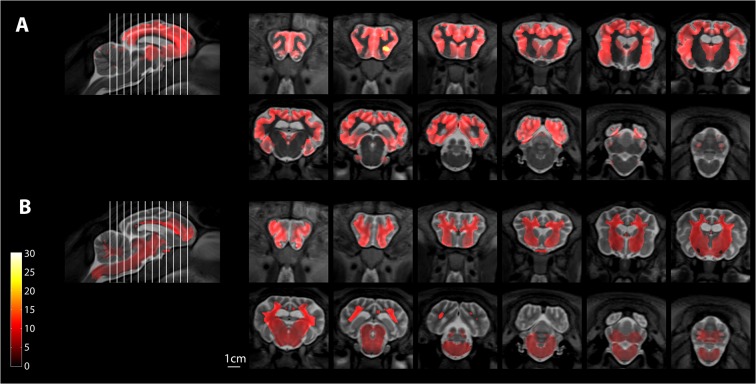
Voxel-based morphometry results showing differences between control sheep and Batten affected sheep, at the baseline scan.Coronal sections are pseudocoloured to show changes in grey matter (A), or white matter (B). The colour bar shows Student’s t-score with 8 degrees of freedom. The position of the sequential coronal sections indicated by the lines on the accompanying sagittal section.